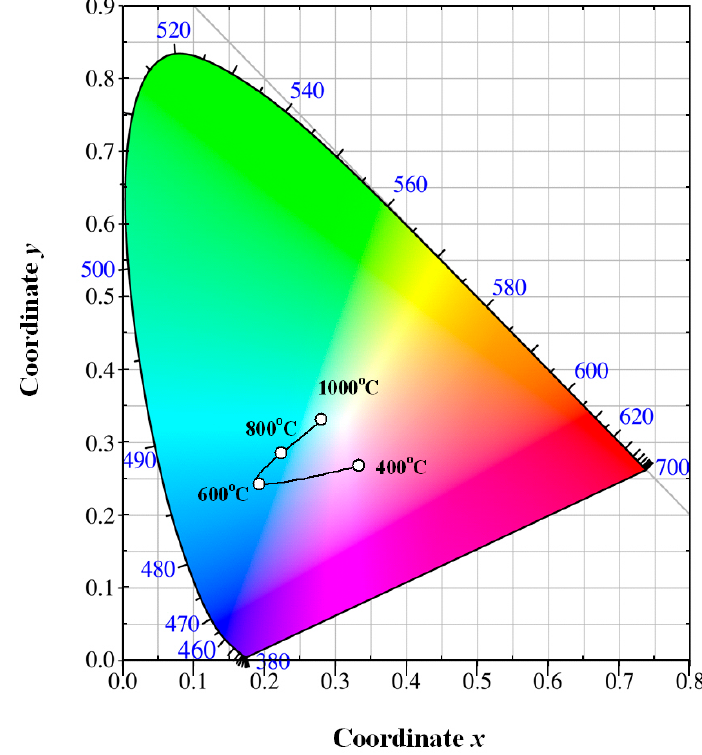
Figure 9. Commission Internationale de L'Eclairage chromaticity diagram of Eu-doped ZnWO 4 precursors subjected to annealing at different temperatures.